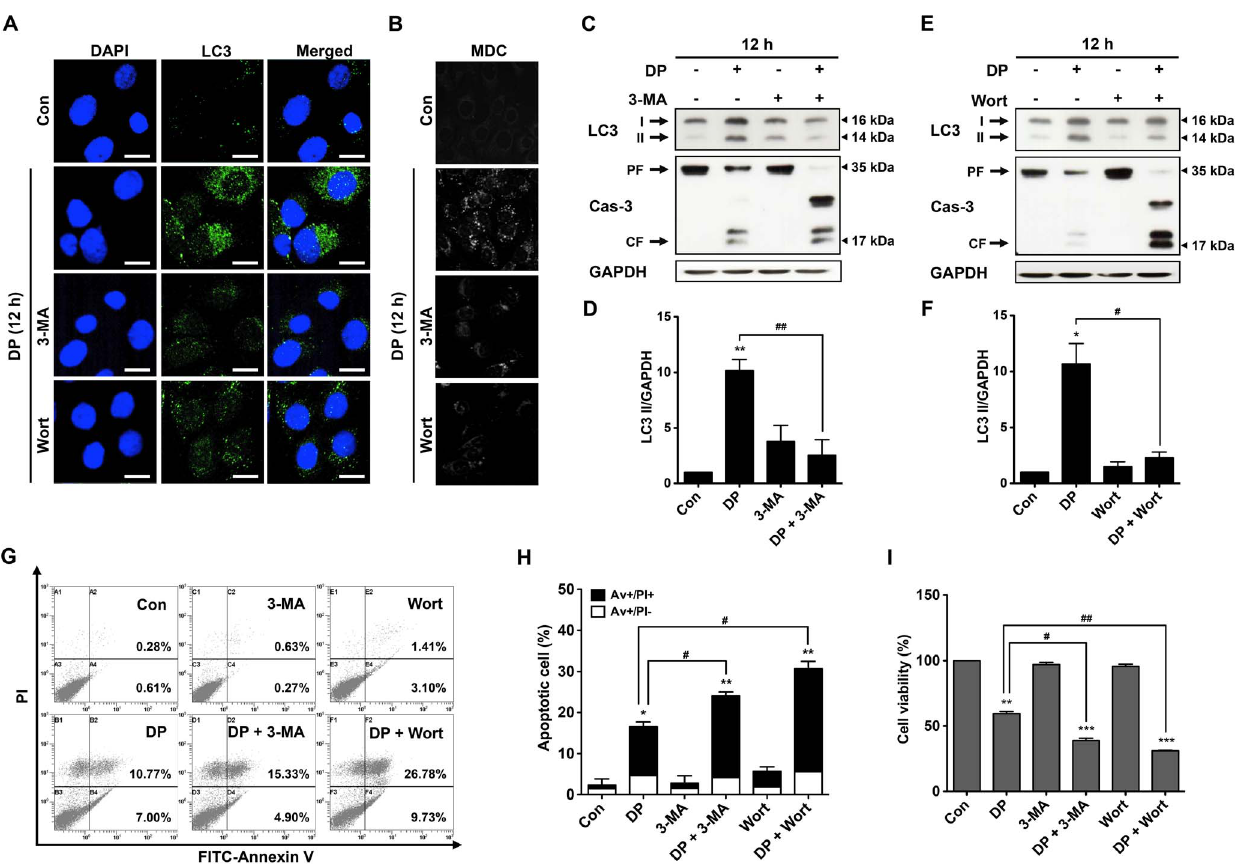
Figure 4. Inhibition of DP-induced autophagy enhanced apoptosis in MG-63 cells. Cells were treated with 60 m M dendropanoxide (DP) for 12 h in the presence or absence of 10 mM 3-MA and 10 m M Wort, after fixation, cells were immunostained with anti-LC3 antibodies (FITC; green). Nuclei were stained with DAPI (blue) and analyzed by using confocal microscopy (scale bars: 20 m m) (A). Autophagic vacuoles were labeled with MDC (bright color) and detected by fluorescence microscopy (B). Representative immunoblot analysis of LC3-II and caspase-3 (Cas-3) protein expression levels (C) and (E). (D) and (F) Densitometric analysis of LC3-II/GAPDH in Fig. 4C and E. The percentage of apoptotic cell was analyzed by flow cytometry for Annexin V/PI staining (G). Quantitative determination of Av + /PI- and Av + /PI + MG-63 cells by flow cytomertry (H). Cell viability was measured by MTT assay (I). Data were expressed as the mean 6 SEM of repeated 3 times experiments. * P , 0.05, ** P , 0.01 and *** P , 0.001 compare with control; # P , 0.05 and ## P , 0.01 compared with